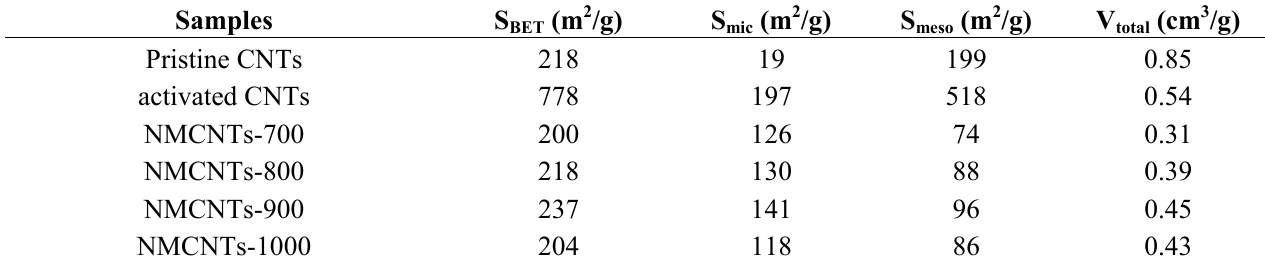
Table 1. Textural properties of the pristine carbon nanotubes (CNTs), activated CNTs and nitrogen- and micropore-containing CNTs